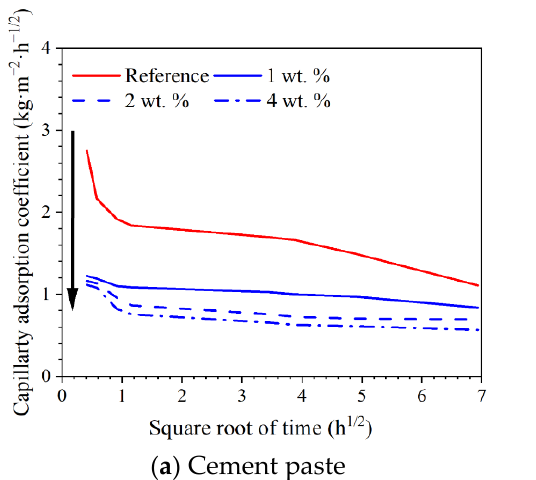
Figure 7. Capillary water absorption coefficient of both cement paste and concrete with different dosages of hydrophobic functional corrosion inhibitor at 28 d of curing.